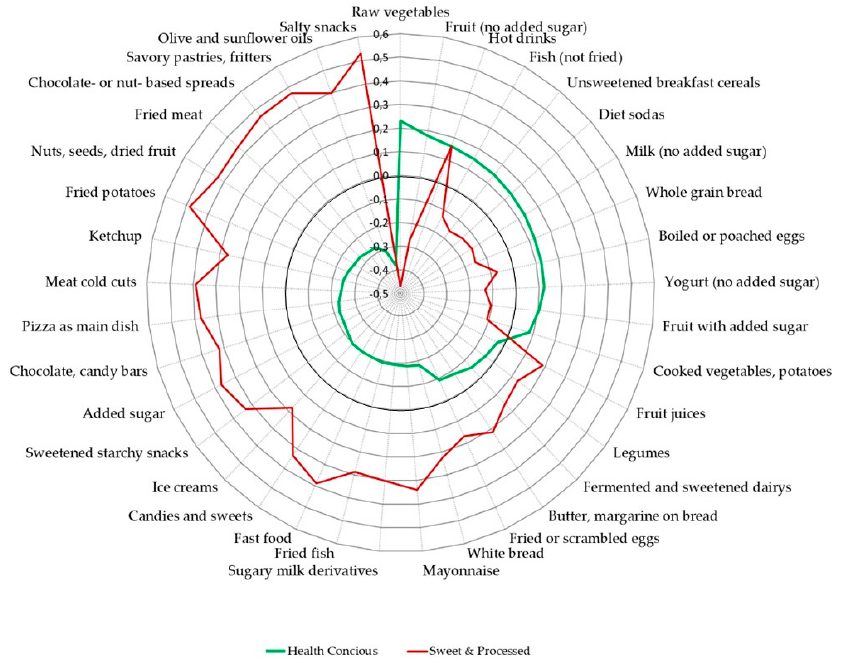
Figure 1. Radar plot of the significant differences ( p < 0.05) in food frequency questionnaire (FFQ) items that characterize each dietary pattern in Spanish children and adolescents.